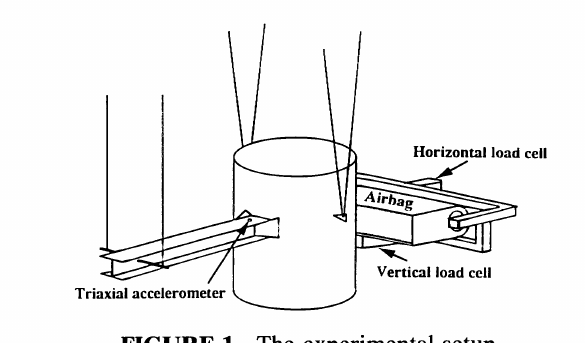
FIGURE 1 The experimental